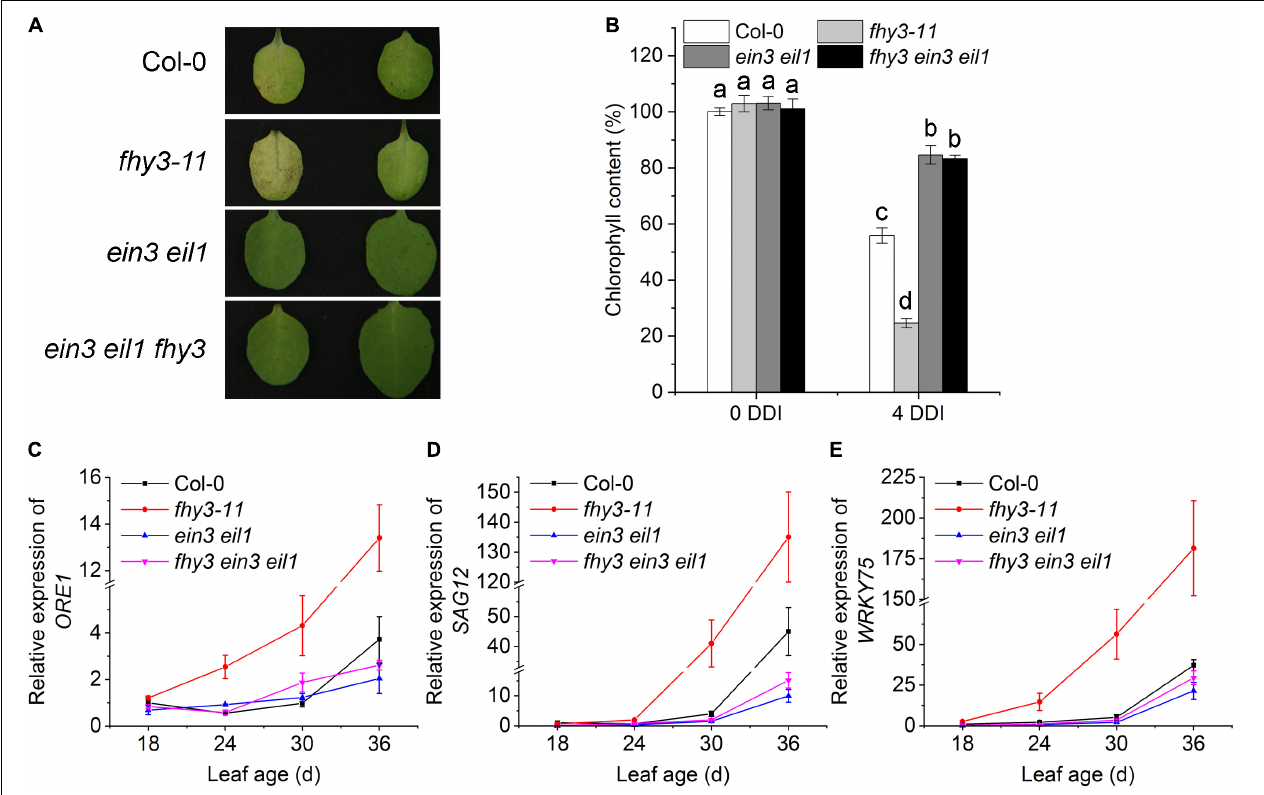
FIGURE 2 | Function of FHY3/FAR1 in regulating leaf senescence depends on EIN3/EIL1 . (A) The senescence phenotypes of the detached leaves of 4-week-old Col-0, fhy3-11 , ein3 eil1, and fhy3 ein3 eil1 plants incubated under darkness for 4 days. (B) The chlorophyll content of the fourth leaves in (A) . Letters indicate significant differences by two-sided LSD test ( p < 0.05). (C–E) Quantitative RT-PCR analysis of the expression of ORE1 (C) , SAG12 (D) , and WRKY75 (E) in the fourth leaves of Col-0, fhy3-11 , ein3 eil1 , fhy3 ein3 eil1 at the indicated leaf age. Error bars represent SD ( n =